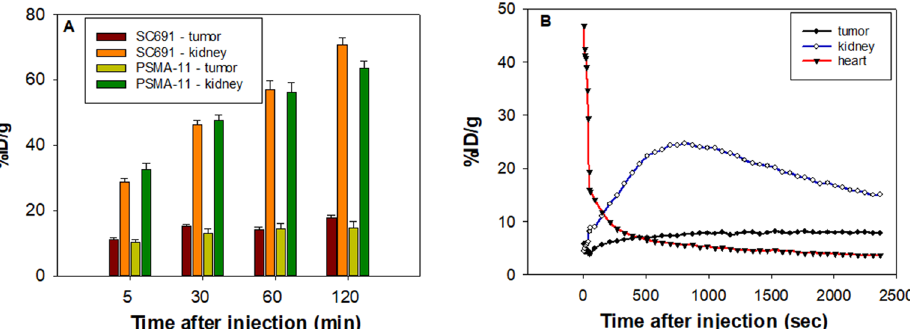
Figure 8. The % ID/g obtained from the whole-body coronal micro-PET/CT scans of NOD/SCID male mice bearing LNCaP tumor xenografts ( A ). The tumor-targeting efficacy of 68 Ga-SC691 was demonstrated by dynamic micro-PET scanning ( B